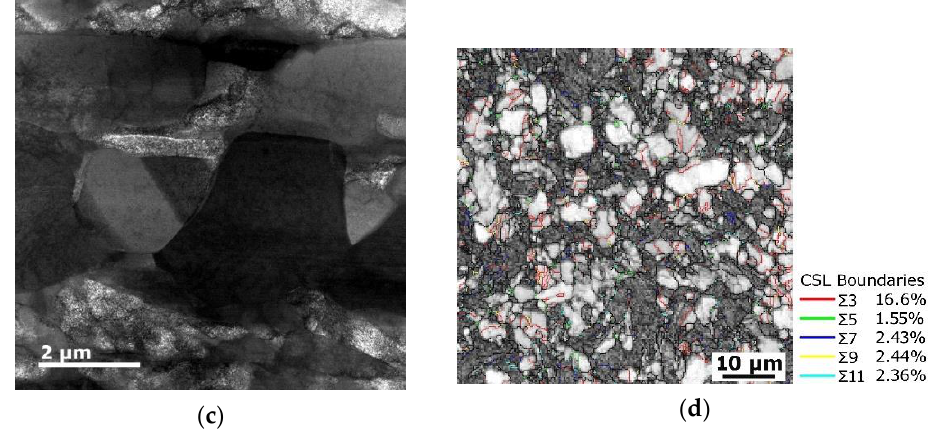
Figure 10. Scanning transmission electron microscopy (STEM) dark field (DF) images of Cu lamella of 15 mm composite–development of subgrains ( a ); accumulated dislocations ( b ). STEM DF image of Cu lamella of 10 mm composite–restored grains ( c ). Detailed SEM-EBSD scan of Cu lamella of 10 mm composite showing CSL boundaries ( d ).